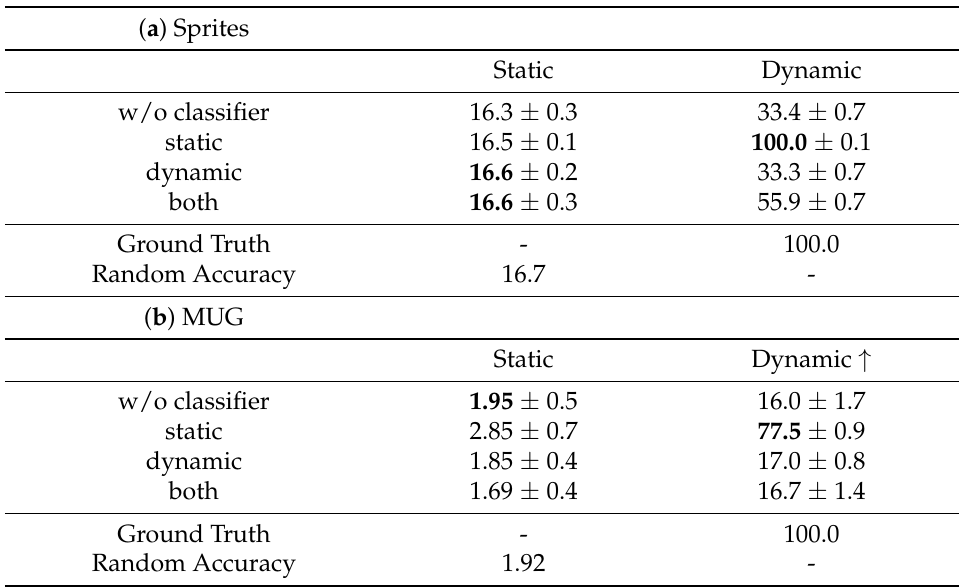
Table A2. Average classification accuracy over ten runs for randomly sampled static features and fixed dynamic features